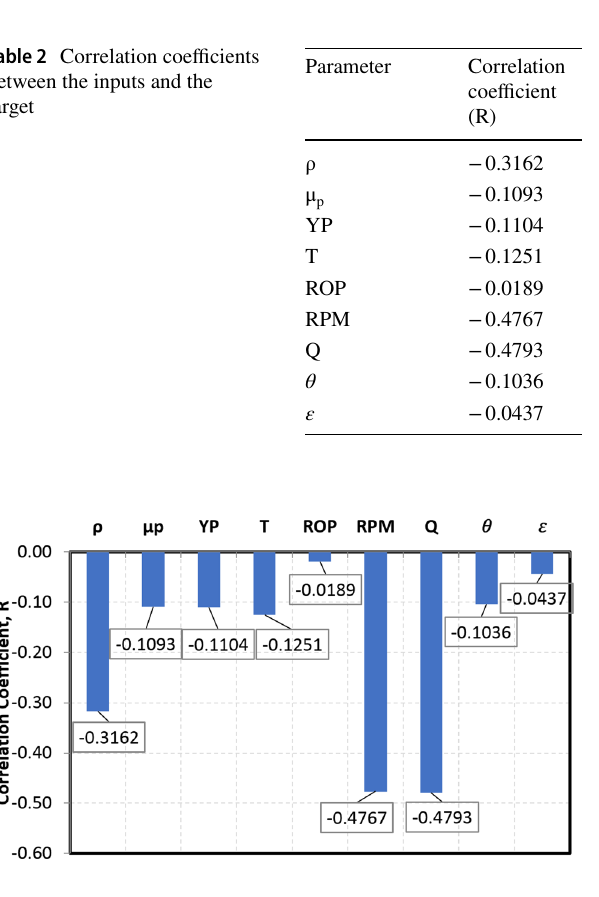
Fig. 3 The correlation coefficient between the input parameters and the cutting